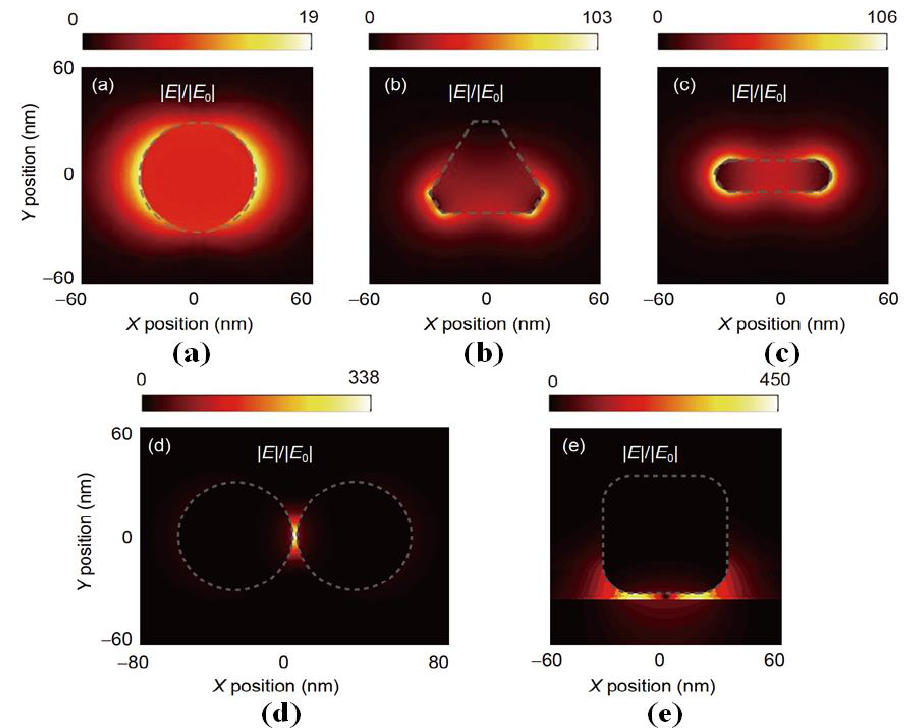
Figure 11. Electromagnetic calculations of near-field distributions of different silver nanoparticles. ( a ) Nanosphere (diameter 60 nm) with a maximum field enhancement factor of 19; ( b ) nanoprism (edge: 60 nm; thickness: 20 nm) with a maximum enhancement factor of 103; ( c ) nanorod (length: 60 nm; width: 15 nm) with a maximum enhancement factor of 106; ( d ) silver nanosphere dimer (diameter: 60 nm; gap: 2 nm) with a maximum enhancement factor of 338; ( e ) silver nanocube over mirror system (cube side length: 65 nm; gap: 3 nm) with a maximum enhancement factor of 450. The gap modes of the coupled systems in ( d , e ) have stronger field enhancement when compared with the single nanoparticle plasmon modes in ( a – c )